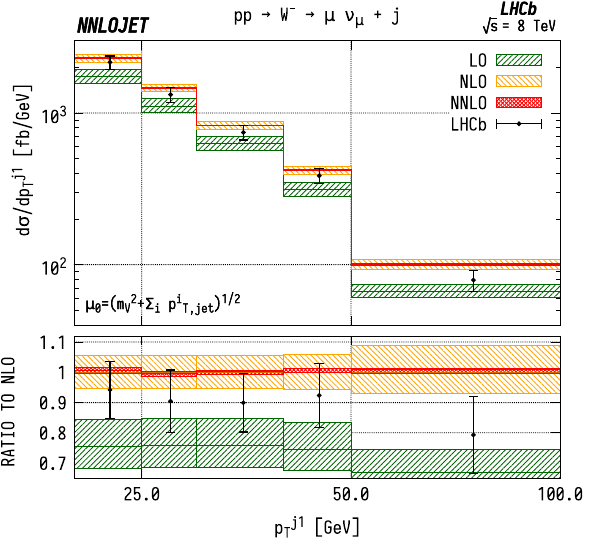
Fig. 5 Cross section differential in the p T of the leading jet for Z production. See Fig. 3 for